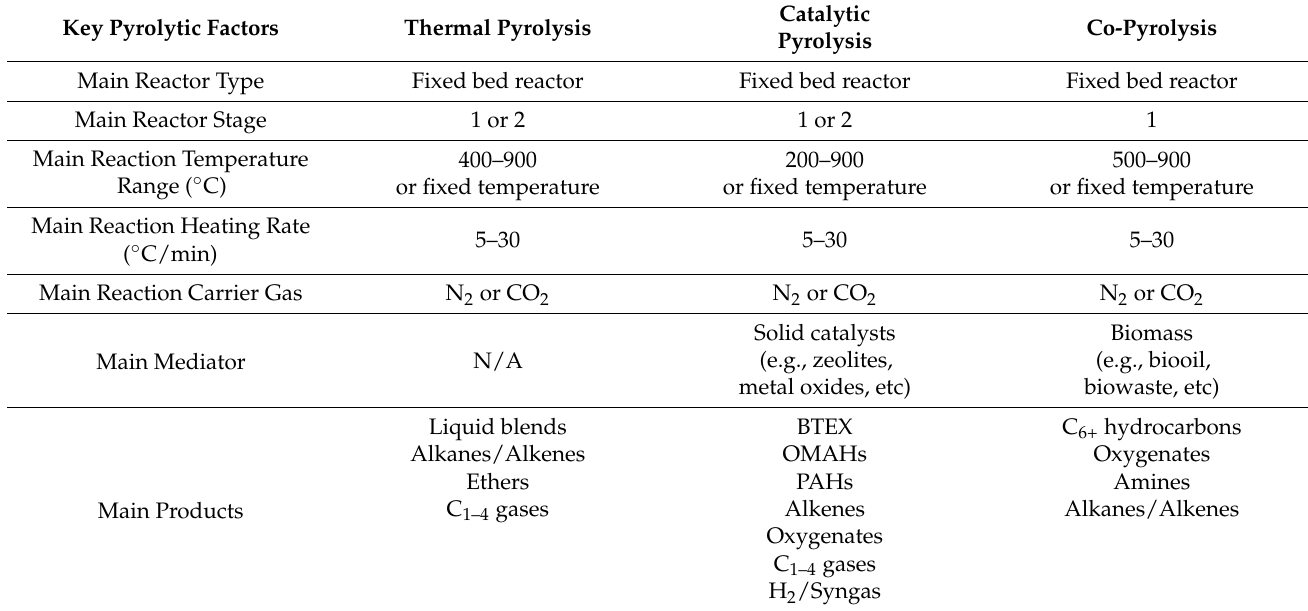
Table 3. Comparison of various pyrolytic